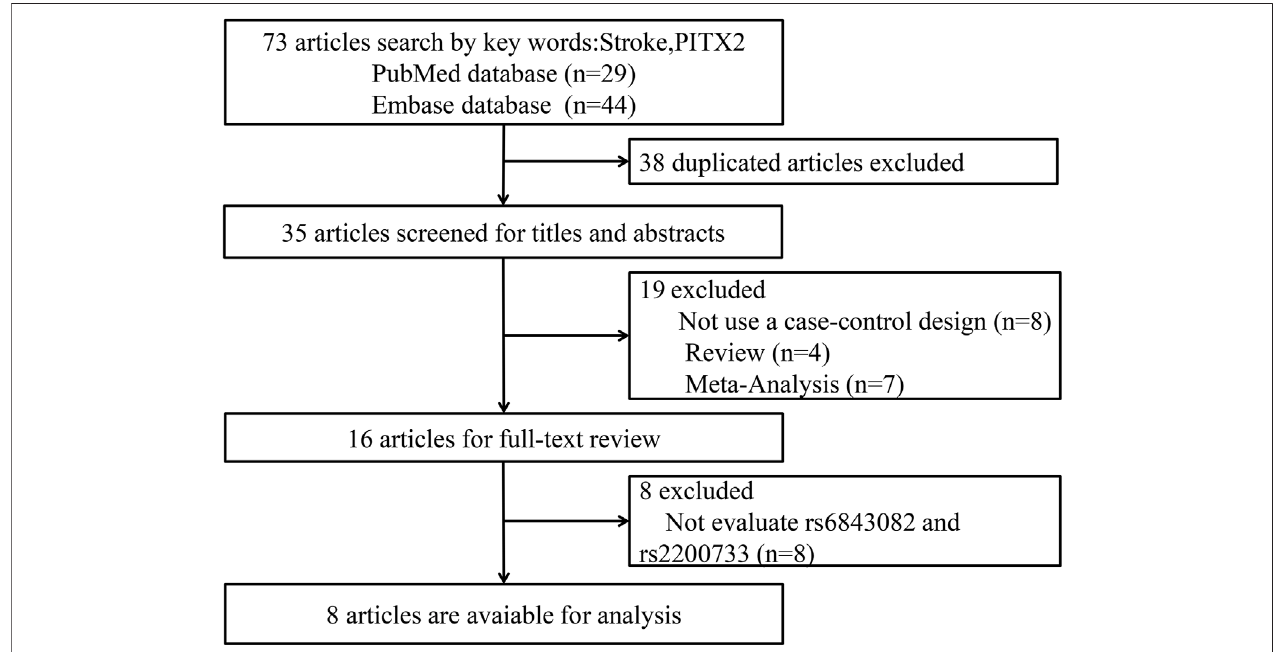
FIGURE 1 | Flowchart of the selection of studies included in this meta-analysis.